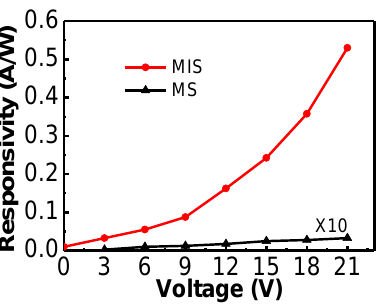
Figure 8. Responsivity as a function of applied voltage for the Au/MgO/MgZnO MIS and Au/MgZnO MS photodetectors. The responsivity of the MIS detector increased exponentially, meanwhile the MS detector showed a linear behavior. Reproduced from [37] with permission of the American Chemical Society (2010).